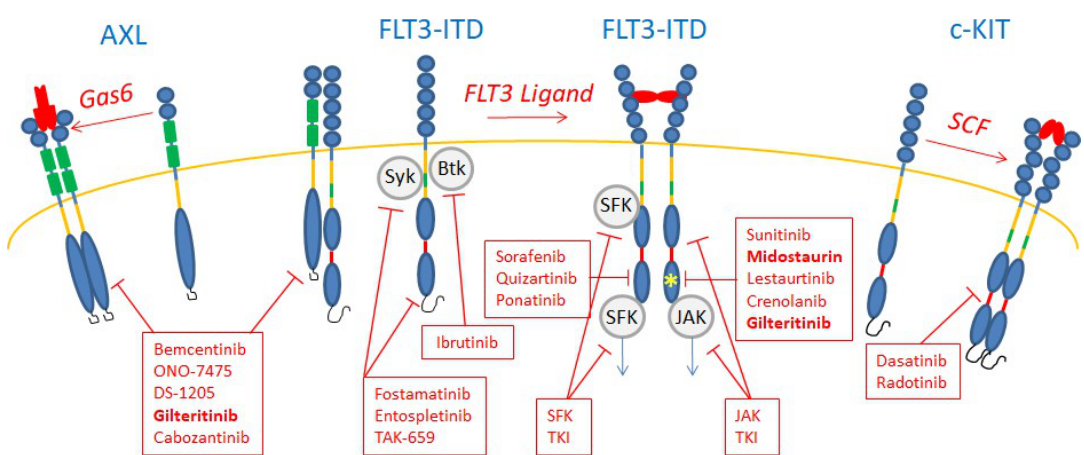
Figure 2. Tyrosine kinase inhibitors in FLT3-ITD AML. Midostaurin and gilteritinib are shown in bold as the only two FDA-approved TKIs. All the others are under development and most are being tested in clinical trials. Those still in preclinical development are not presented.